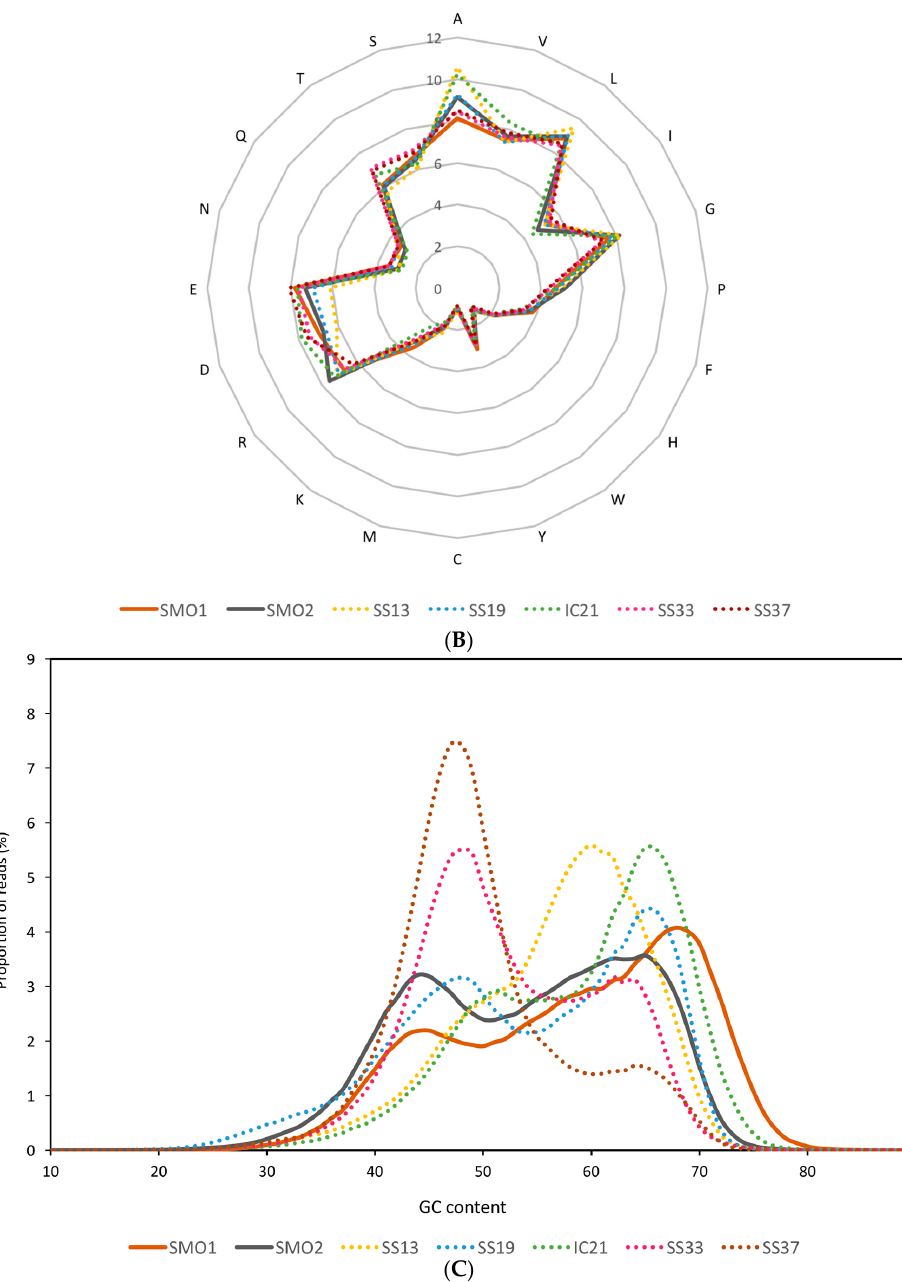
Figure 1. General characteristics of the saline soil metagenomic datasets, as compared to saltern metagenomic databases: ( A ) Isoelectric point of predicted proteins computed for each translated read and shown as a percentage of the total reads in the dataset, in intervals of bin width 2; ( B ) Frequency of use of amino acids of the predicted proteins; ( C ) GC content of the reads. Databases used are described in Table 1.